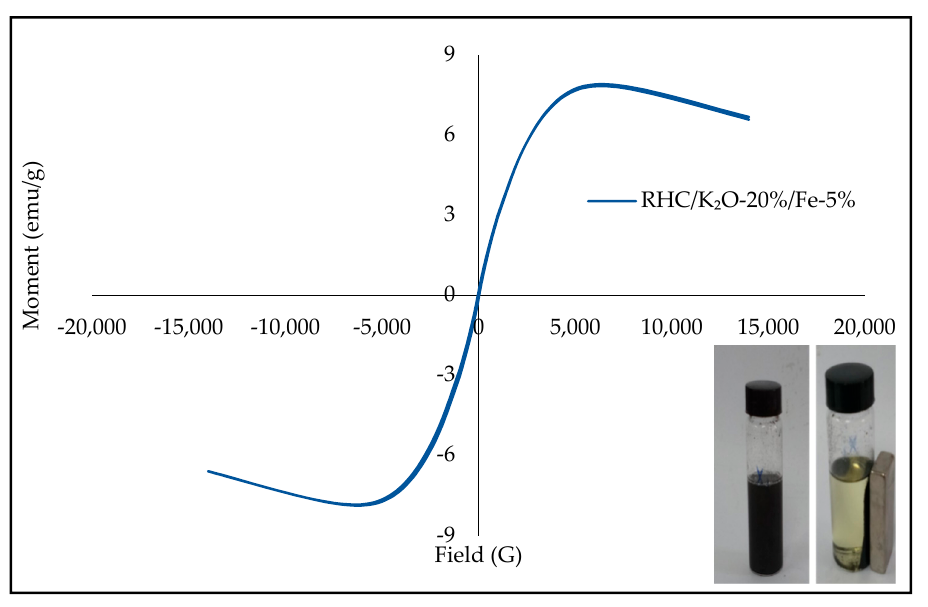
Figure 5. Vibrating sample magnetometer (VSM) magnetization curve of RHC/K 2 O-20%/Fe-5% catalyst and the magnetic separation of the catalyst from biodiesel.